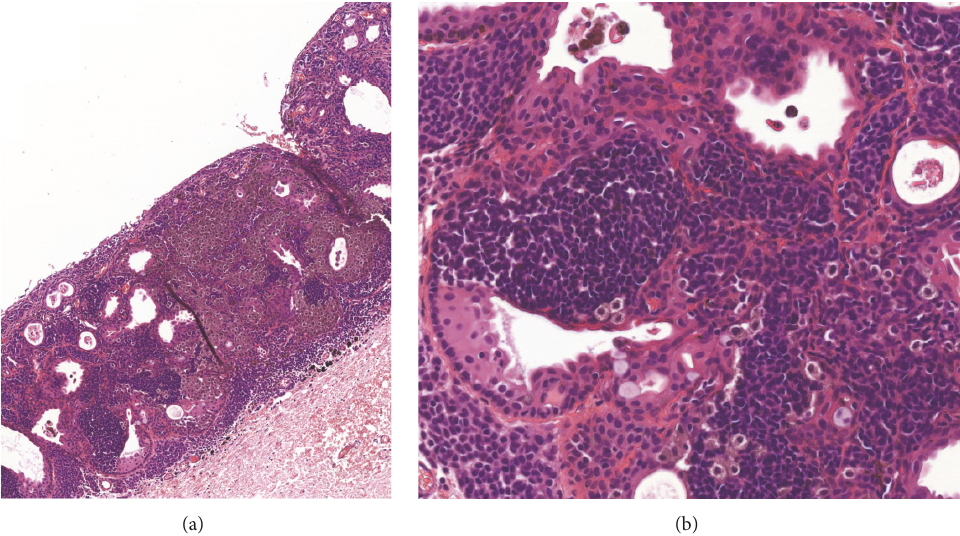
Figure 3: Histological examination revealed nevus cell nests with vertical maturation tendency and junctional activity in the epithelial- stromal border of the conjunctiva. Multiple cysts and intratumoral vessels could also be detected (magnification: (a) 10x, (b)